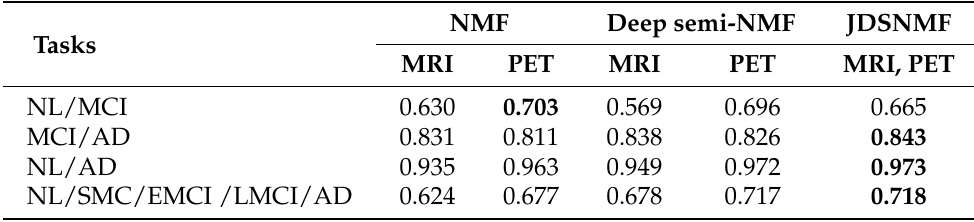
Table 2. Performance comparison of NMF, deep semi-NMF, and JDSNMF on bioimaging data. Bold text indicates the best